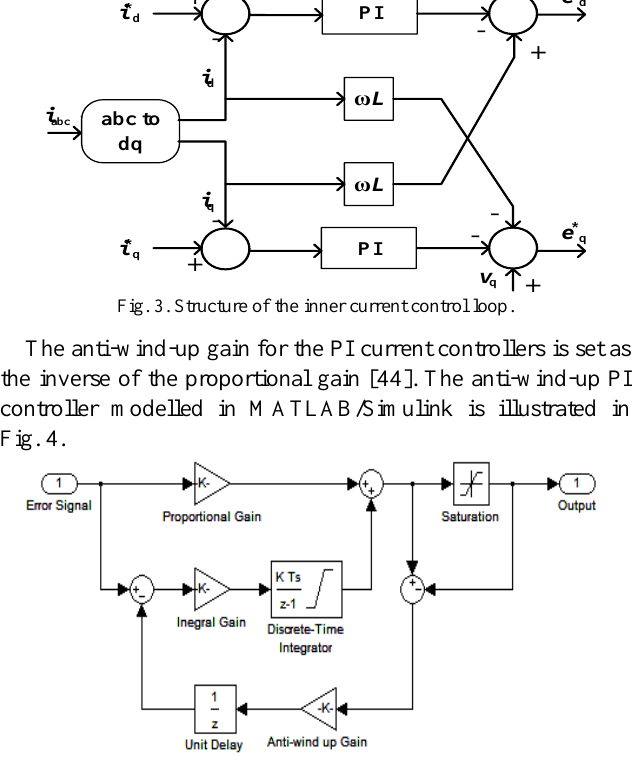
Fig. 4. Anti-wind-up PI controller modelled in MATLAB/Simulink.